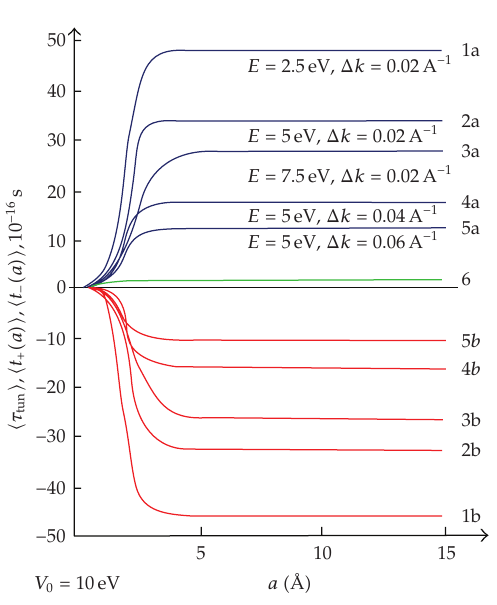
(cid:8) and (cid:7) t (cid:8) (cid:2) 0 (cid:3) (cid:8) from a tun